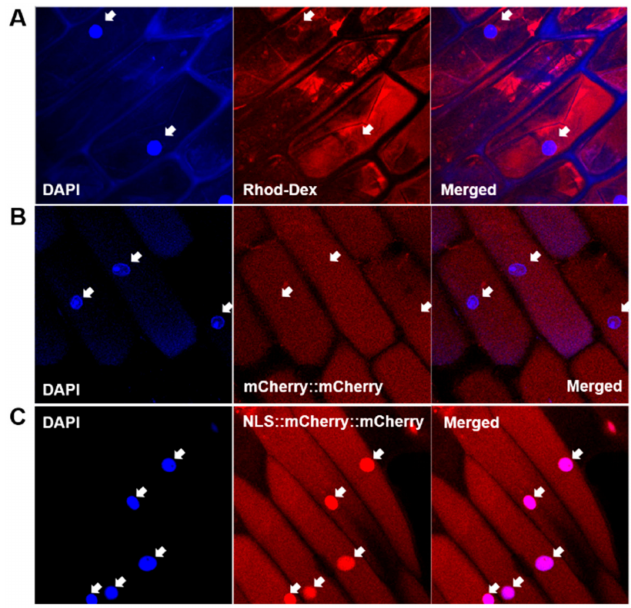
Figure 1. Establishment of nuclear import assay system using onion cell strips. ( A ) Cytoplasmic accumulation of rhodamine-dextran (70 kDa) after permeabilization of plasma membrane with 0.2% Triton X-100. ( B ) Cytoplasmic accumulation of mCherry::mCherry protein (53.4 kDa). ( C ) Cyto- plasmic and nuclear accumulation of nuclear localization signal (NLS)::mCherry::mCherry protein. Arrows indicate the location of